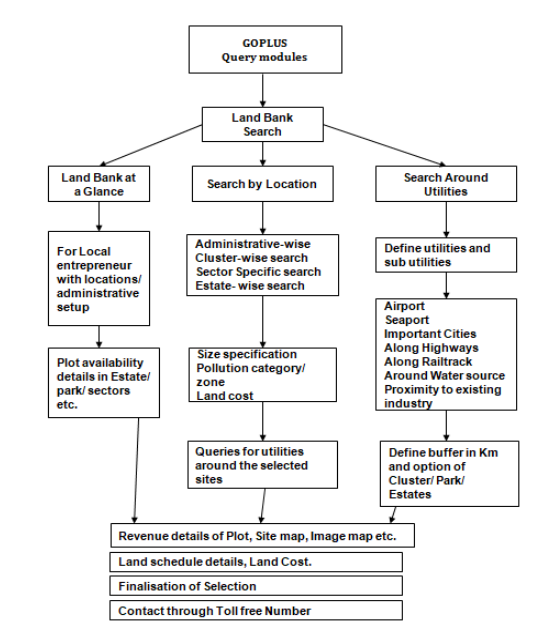
Figure 4. Land Bank at a glance module to obtain land